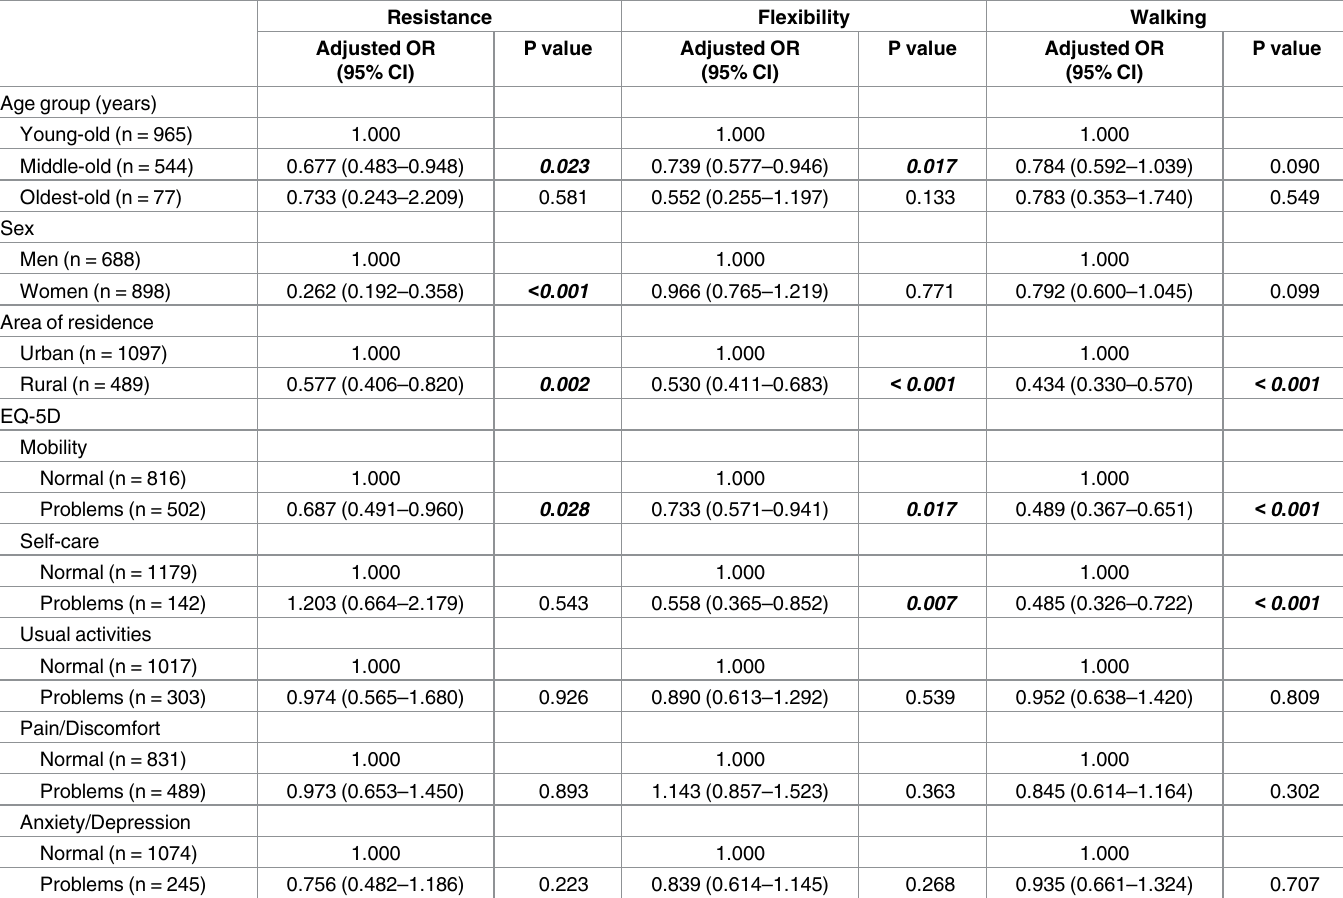
Table 3. Adjusted odds ratios for the three